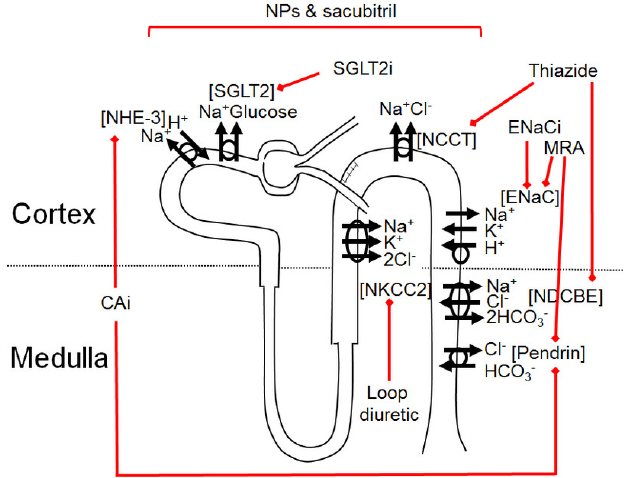
Figure 1. Diuretics and their action in the nephron. Almost all components of the tubule involved in sodium retention can be targeted by existing diuretics, paving the way to sequential nephron blockade. The proximal tubule is targeted by SGLT2 inhibitors, natriuretic peptides (increased in patients treated with sacubitril), and carbonic anhydrase inhibitors. The loop of Henle and the proximal and distal convoluted tubule are targeted by loop and thiazide diuretics, respectively. Sodium retention in the collecting duct is mainly hindered by mineralocorticoid receptor antagonists and ENaC inhibitors. [SGLT2]: sodium–glucose cotransporter-2, [NHE-3]: Na + /H + exchanger type 3, [NKCC2]: sodium–potassium–chloride cotransporter type 2, [NCCT]: sodium–chloride cotransporter, [NDCBE]: Na + -driven Cl − /HCO 3− exchanger, [ENaC]: epithelial sodium channel, SGLT2i: sodium–glucose cotransporter-2 inhibitors, NPs: Natriuretic Peptides, MRA: Mineralocorticoid Receptor Antagonists, ENaCi: Epithelial sodium channel inhibitor, CAI: carbonic anhydrase inhibitor.